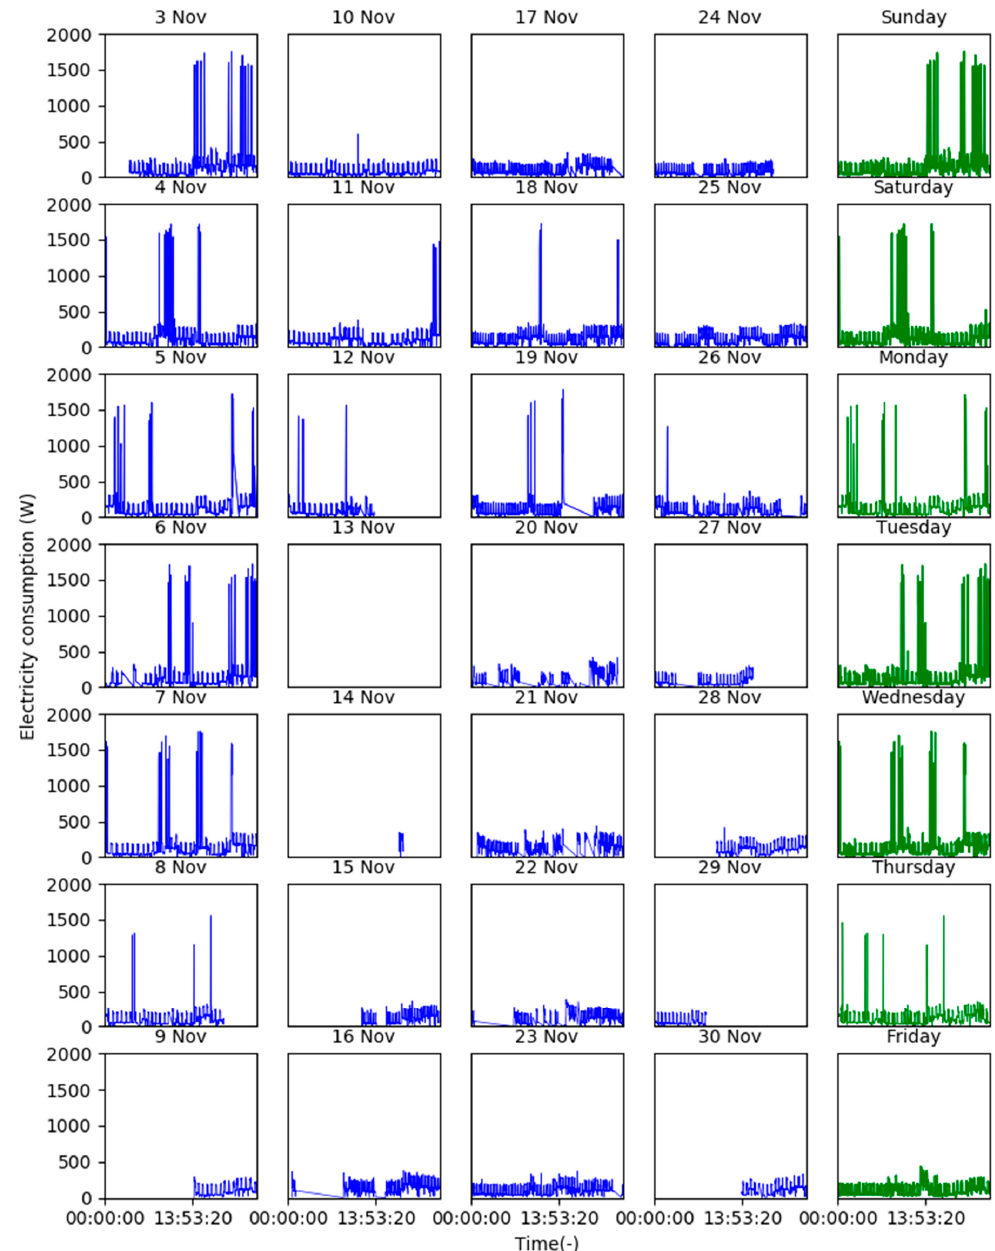
Figure 5. (Blue) electricity consumption data of November 2018; (Green) representative electricity consumption profiles for the week of 3–9 November